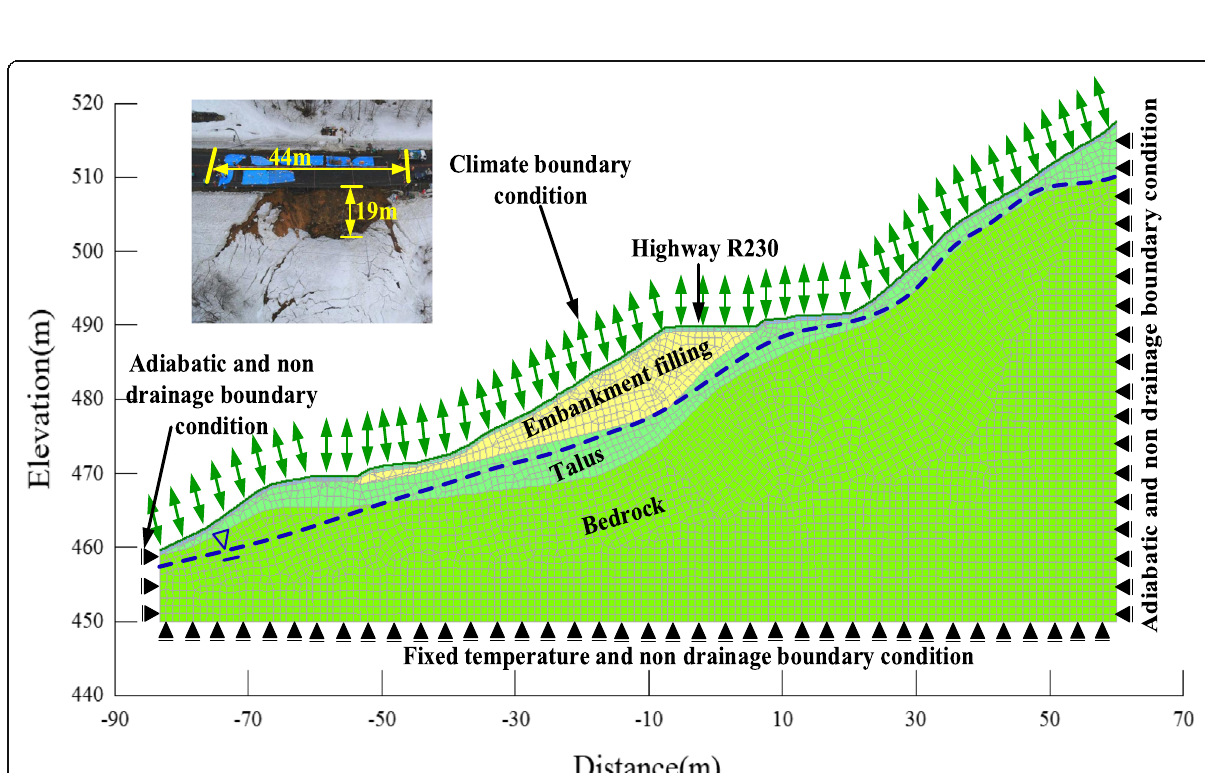
Fig. 12 2D numerical highway slope model at Nakayama Pass